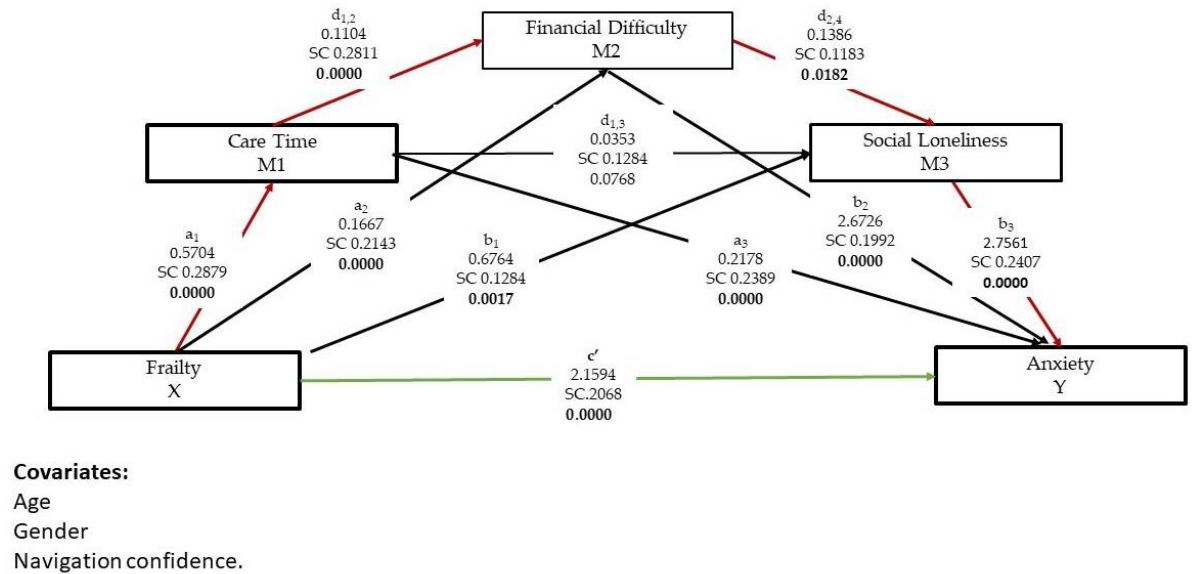
Figure 3. The serial mediating effects of care time, financial difficulty and social loneliness in a relationship between frailty and anxiety. Table 4. Serial mediators in the relationship between caregiver frailty and anxiety. Model Pathways.